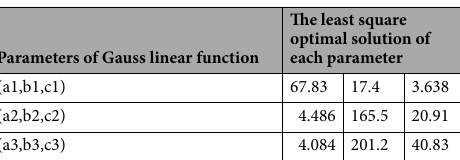
Parameters of Gauss linear function